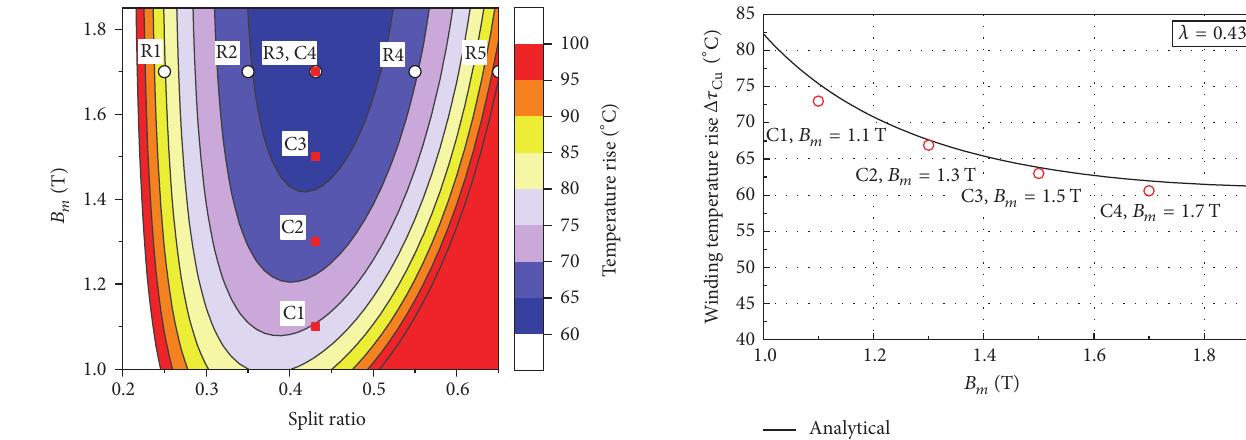
Figure 4: Analytical contour of the winding temperature rise and the points used for FEA verifications. Table 2: Analytical and FEA results of different designs ( Δ𝜏 Cu . Anl and Δ𝜏 Cu . FEA are the analytical and FEA winding temperature rise).